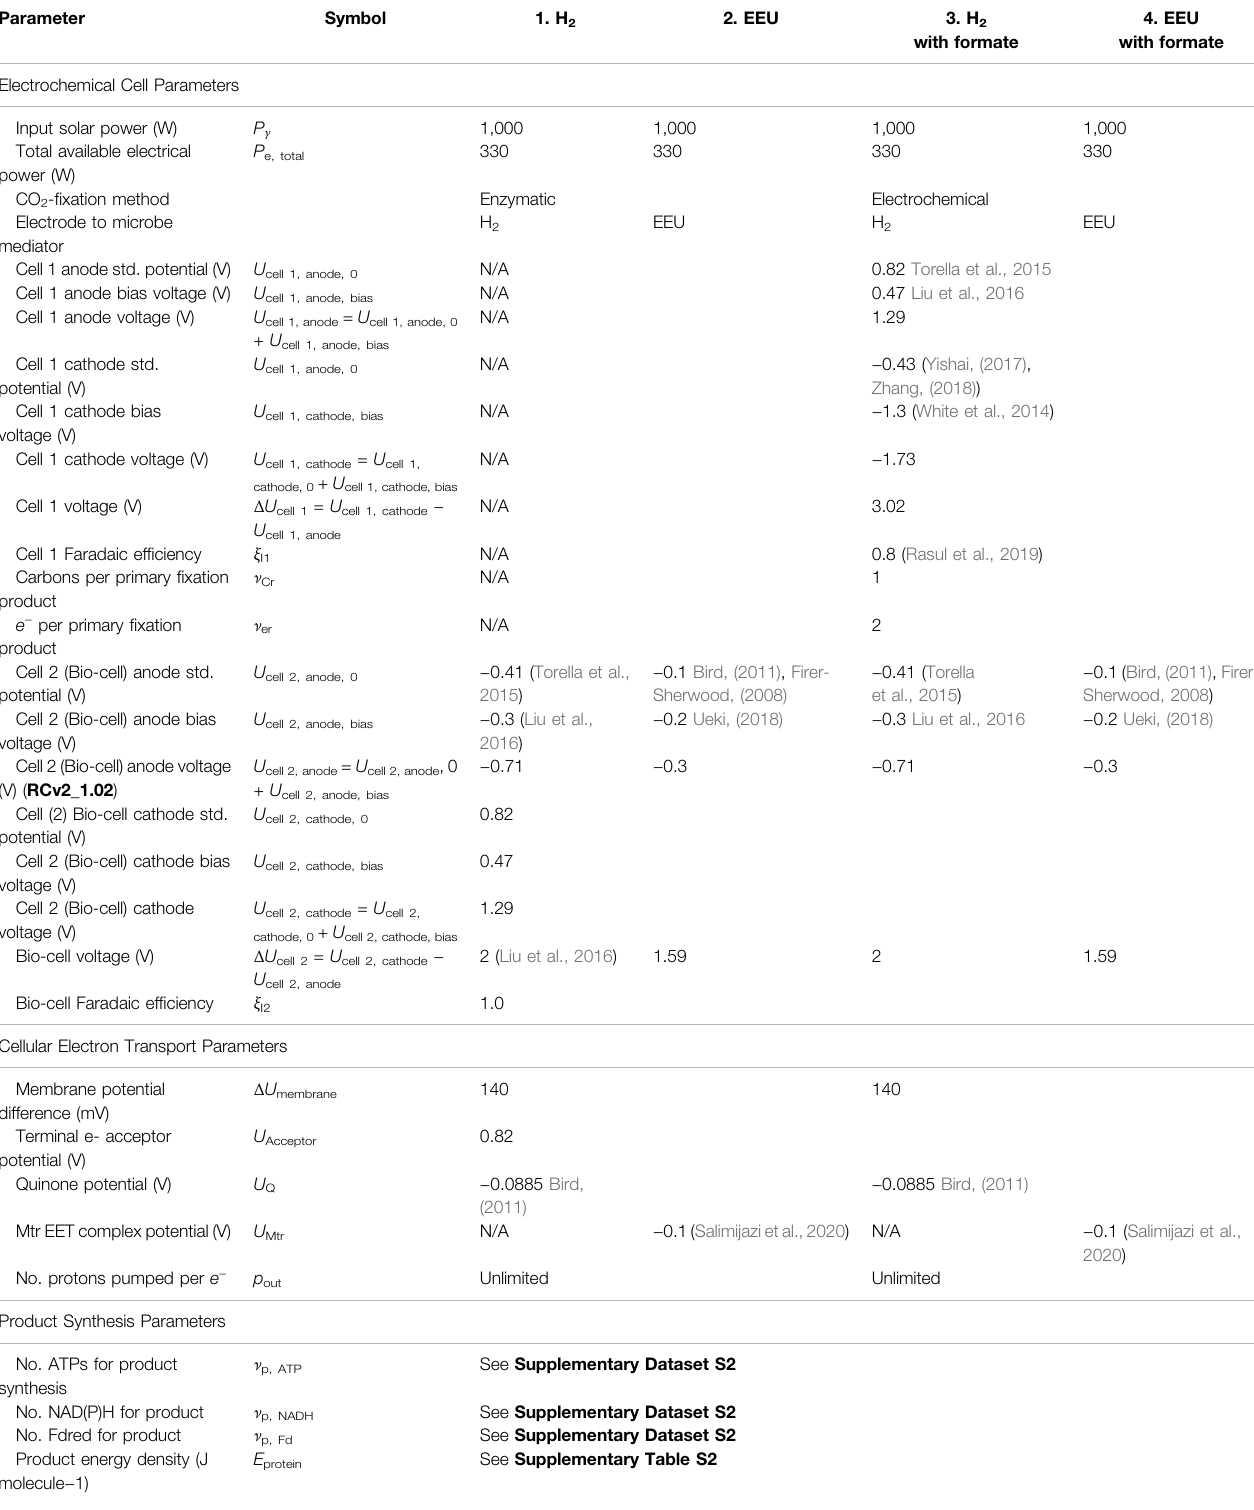
TABLE 1| Electromicrobialproteinproduction modelparameters. Modelparametersused inthisarticlearebaseduponmodelparameters usedinapreviousanalysisofthe electromicrobialproduction ofthebiofuelbutanol (Salimijazietal.,2020).Asensitivity analysiswasperformedforallkeyparameters inthiswork(Salimijazietal.,2020).A complete list of symbols used in this work (including symbols for outputs, and intermediate variables) is included in Supplementary Table S1